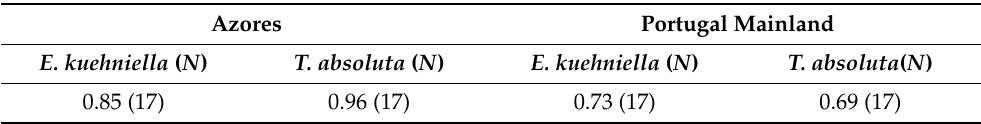
Table 2. Survival rate of the immature stages of Macrolophus pygmaeus from the Azorean population and Portugal mainland fed on single diets of Ephestia kuehniella or Tuta absoluta eggs (25 ± 1 ◦ C; 75 ± 5% relative humidity and light regime 16L:8D).